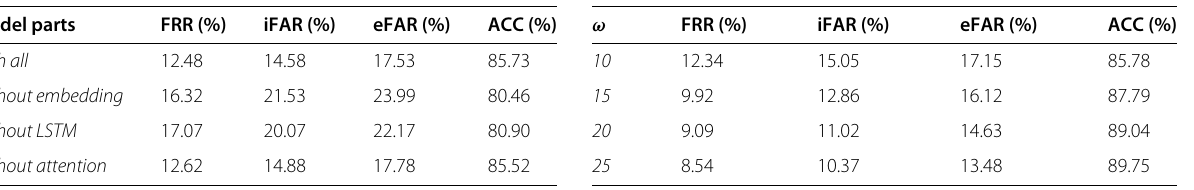
Table 4 The effect of different parts of the keystroke model on classifiers performance